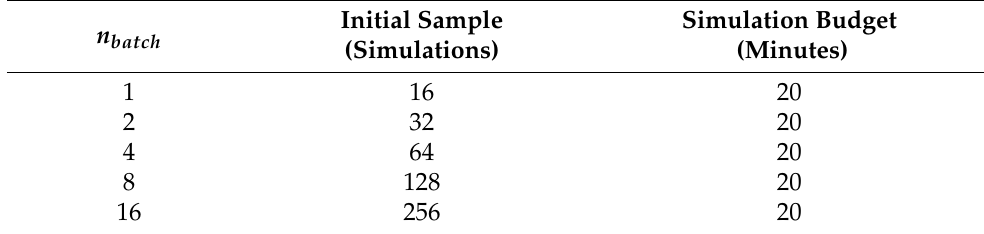
Table 2. Allocation of the budget according to available computing power (i.e., n batch ).